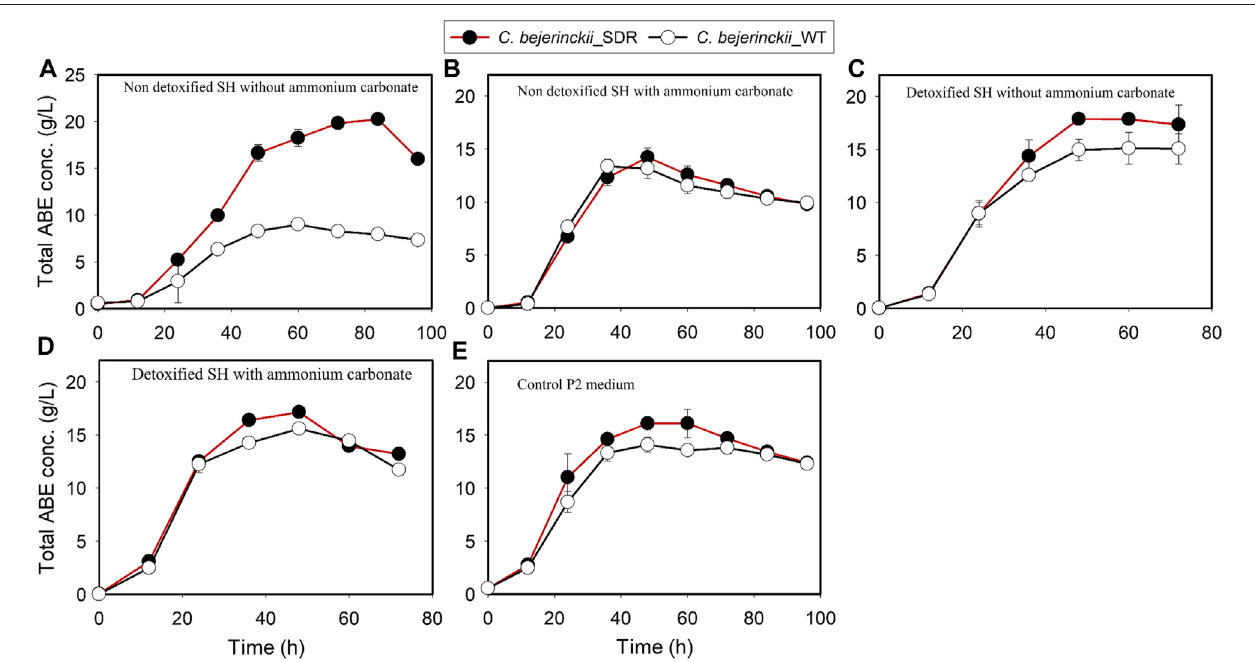
FIGURE 8 | ABE concentrations in cultures of C. beijerinckii _SDR and C. beijerinckii _wildtype grown in SH and P2 medium control. (A) Non-detoxi fi ed SH without ammonium carbonate. (B) Non-detoxi fi ed SH with ammonium carbonate. (C) Detoxi fi ed SH without ammonium carbonate. (D) Detoxi fi ed SH with ammonium carbonate. (E) Control P2